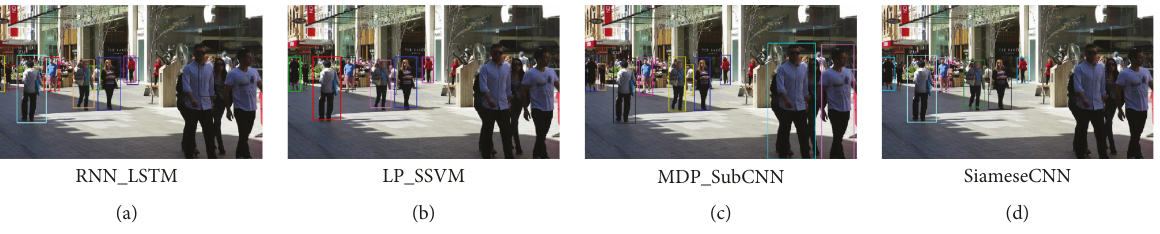
Figure 12: Sample tracking results of other trackers on frame number 240 of ADL-Rundle-3.